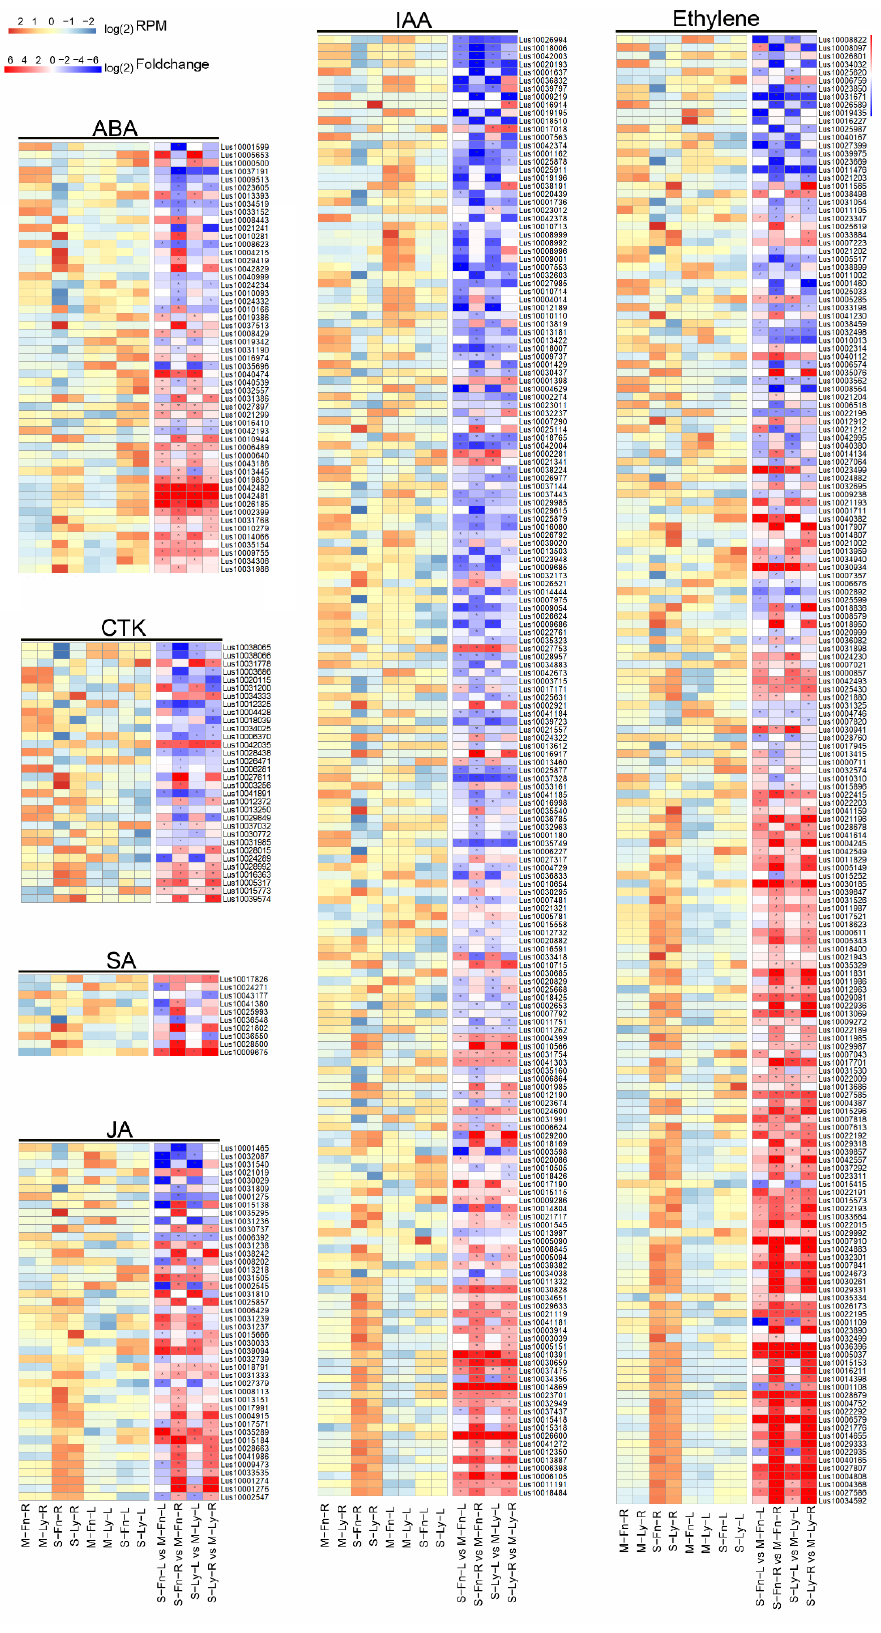
Figure 6. Expression of genes related to plant hormones between root and leaf in Fanni and Longya10 under saline stress. M–Fn–R and M–Ly–R represent the root samples derived from